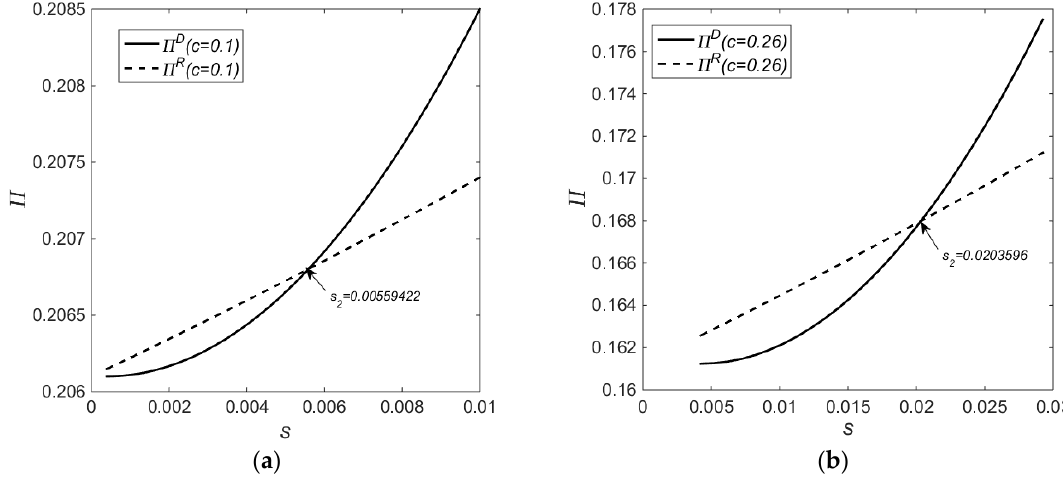
Figure 2. Impact on the OEM’s Profits by Different Subsidy Levels; ( a ) =0.1 c , ( b ) 0.26 c = .